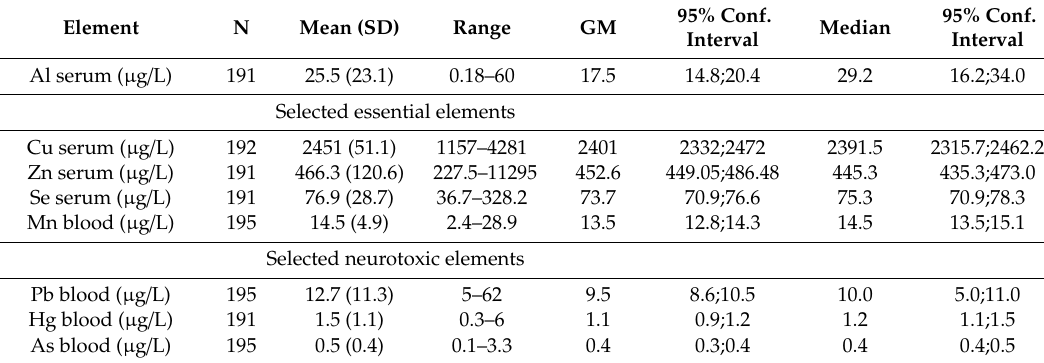
Table 4. Concentration of Al, selected essential and neurotoxic elements in whole blood or serum (as indicated).